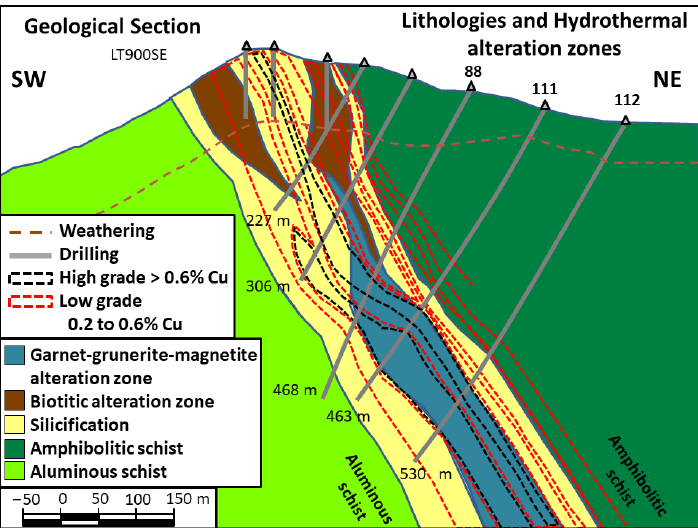
Figure 4. Geological section with the host rocks, hydrothermal alteration zones and mineralized zones. High-grade orebodies with values higher than 0.6% copper (modified from Vale S.A. [42]). Location of the section in Figure 3.